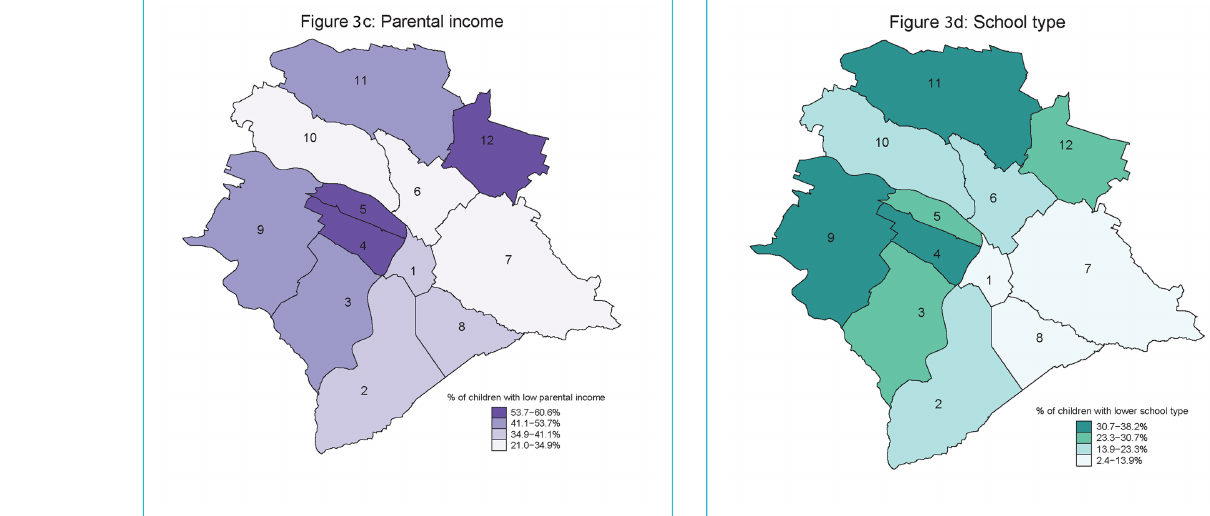
All Children Migration background: Migration background: southern, eastern western and northern Europe ** and outside Europe * n = 5199 n = 2597 n =